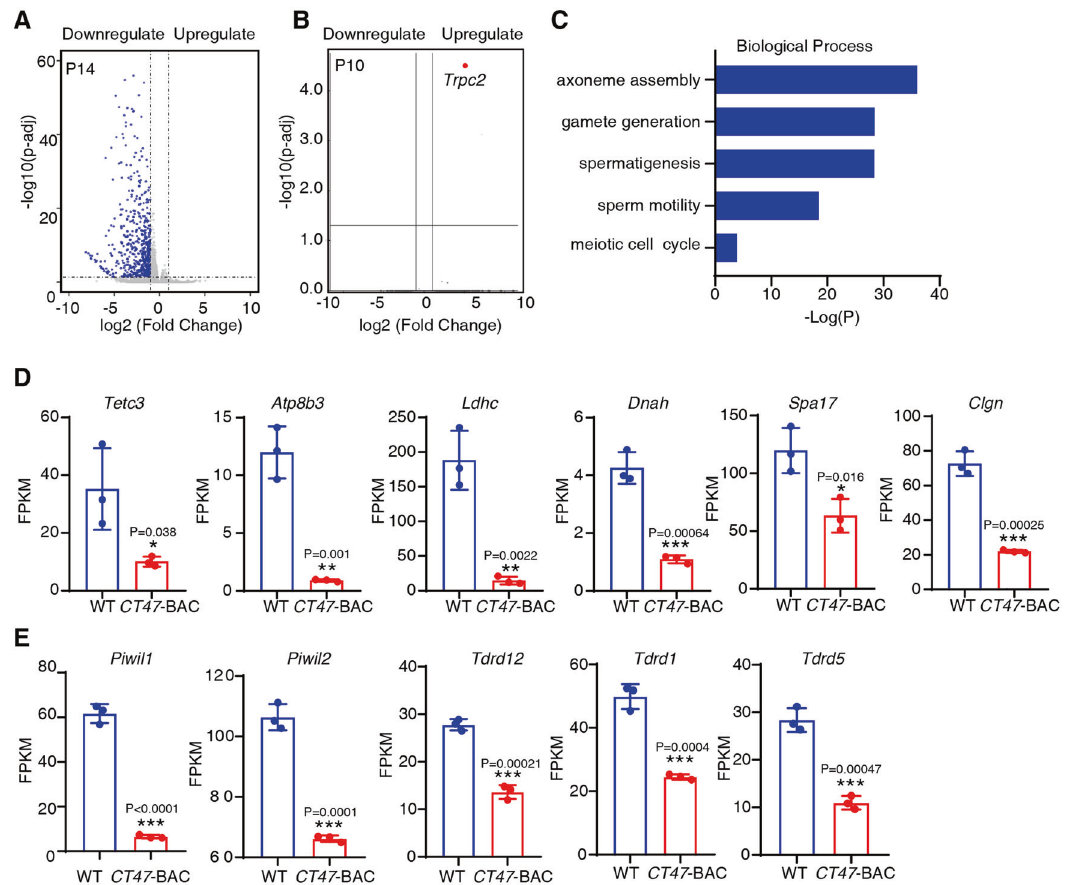
Fig. 5 Pachytene-related genes were signi fi cantly repressed in CT47 -BAC mice. A , B Volcano plot representing differentially expressed genes in the RNA-seq of P14 ( A ) and P10 ( B ) in the indicated testes. Volcano plots for three biological replicates of each genotype are shown. Blue dots represent 539 downregulated genes of P14 CT47 -BAC testes. Red dots represent one upregulated gene of P10 CT47 -BAC testes. The P -adj < 0.05 and log2-fold change ≥ 1 cutoff values. C Gene ontology functional enrichment (GO) of the DEGs arising from P14 CT47 -BAC over WT testes according to the − log ( p value). D RNA-seq analysis of selected genes related to pachytene expression. The mean values ± SD are shown. Student ’ s t test: n = 3 for each group, * p < 0.05, *** p < 0.001. E RNA-seq analysis of piRNA-related genes. The mean values ± SD are shown. Student ’ s t test: n = 3 for each group, * p < 0.05, ** p < 0.01, *** p <